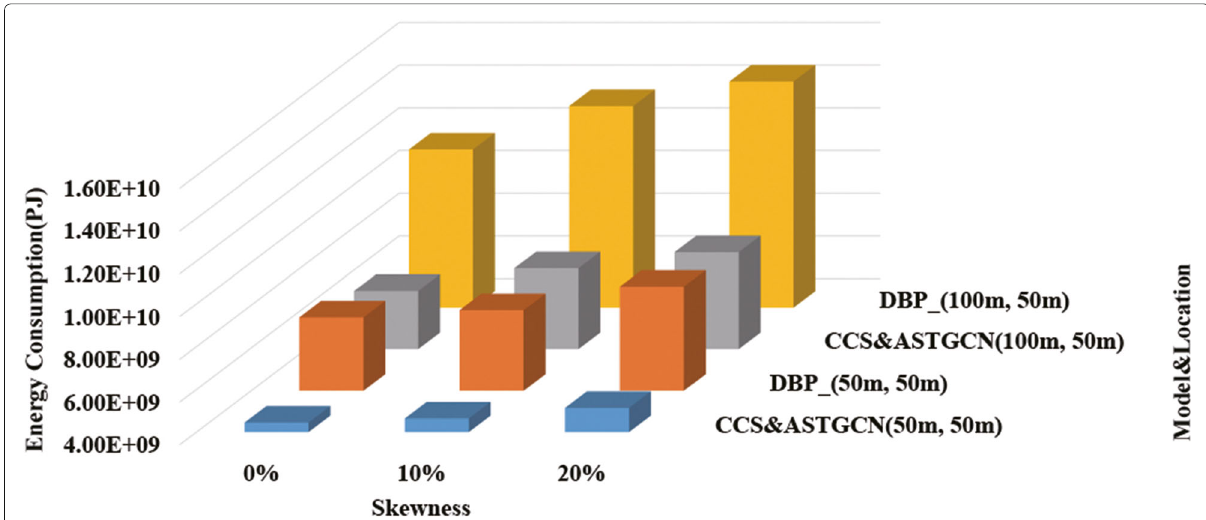
Fig. 8 Comparison of energy consumption of DBP and CCS&ASTGCN mechanism with various skewness of nodes distribution and locations of the